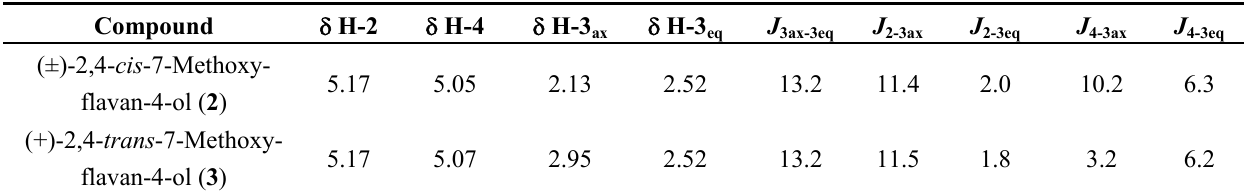
Selected 1 H-NMR (+) - 2,4- trans -7-methoxyflavan-4-ol ( 3 ). Compound 